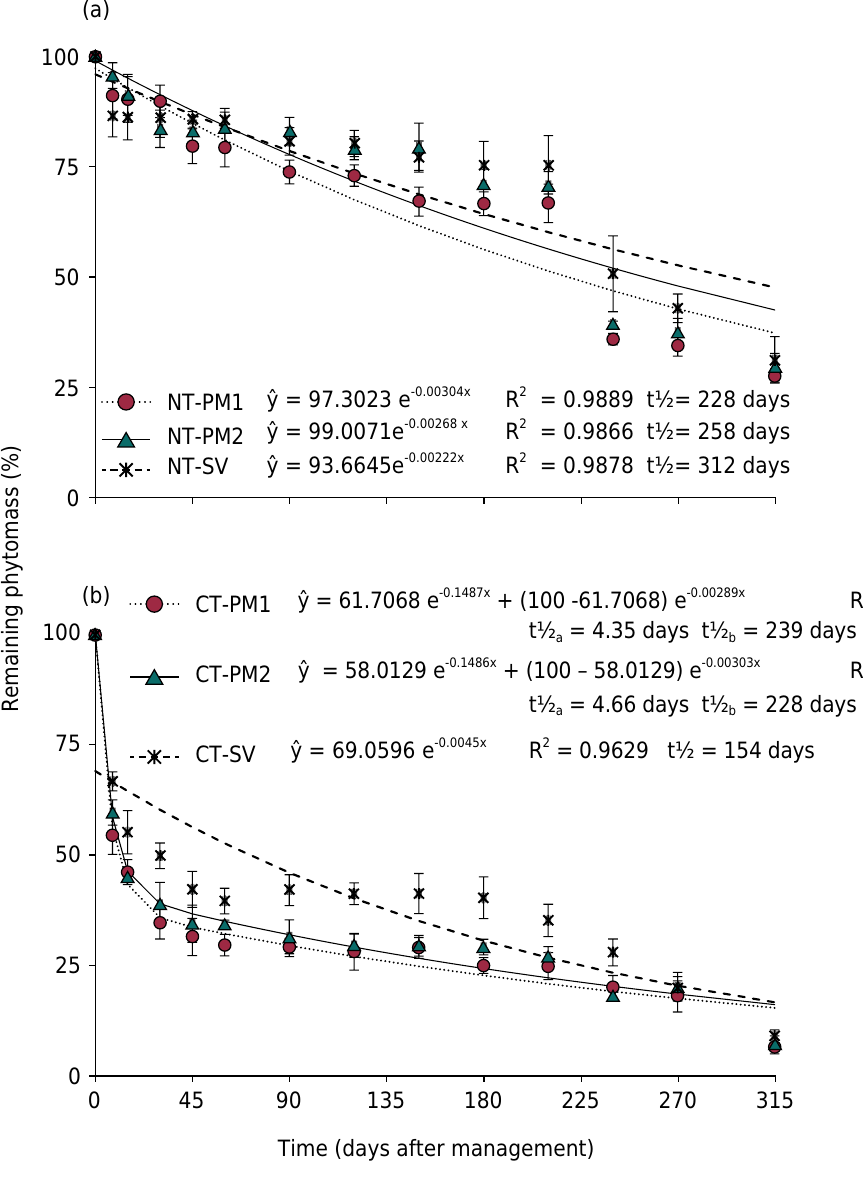
Figure 2. Remaining aboveground phytomass after management of three mixtures of cover crops in mango interrows in Petrolina, Pernambuco State, Brazil. PM1 = 75 % leguminous species + 25 % grass and oilseed species; PM2 = 25 % leguminous species + 75 % grass and oilseed species; and SV = spontaneous vegetation combined with two soil tillage systems (NT = no tillage (a); CT = conventional tillage (b); t ½ = half-life time; t½ a = half-life time of labile compartment; and t ½ b = half-life time of recalcitrant compartment. Bars represent the standard error of the